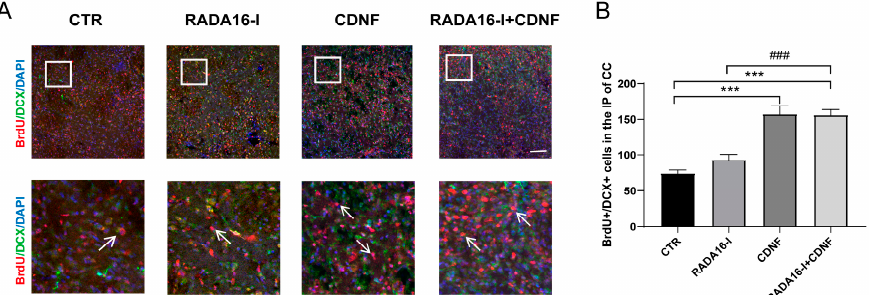
Figure 4. CDNF promoted the migration of neuroblasts in the SVZ into the ischemic penumbra area of MCAO rats. ( A ) BrdU (red)/DCX (green)-positive cells were identified via immunohistochemical staining. DAPI (blue) was used to label the nuclei. The insets show photomicrographs of the ischemic penumbra at higher magnification. Arrows point to the BrdU/DCX-positive cells. Scale bar = 45 µ m. ( B ) Quantitative analysis of BrdU/DCX-positive cells in the ischemic penumbra. N = 5/group. *** p < 0.001 indicates statistical significance between treatment group and CTR group; ### p < 0.001 indicates statistical significance between RADA16-I group and RADA16-I + CDNF group.